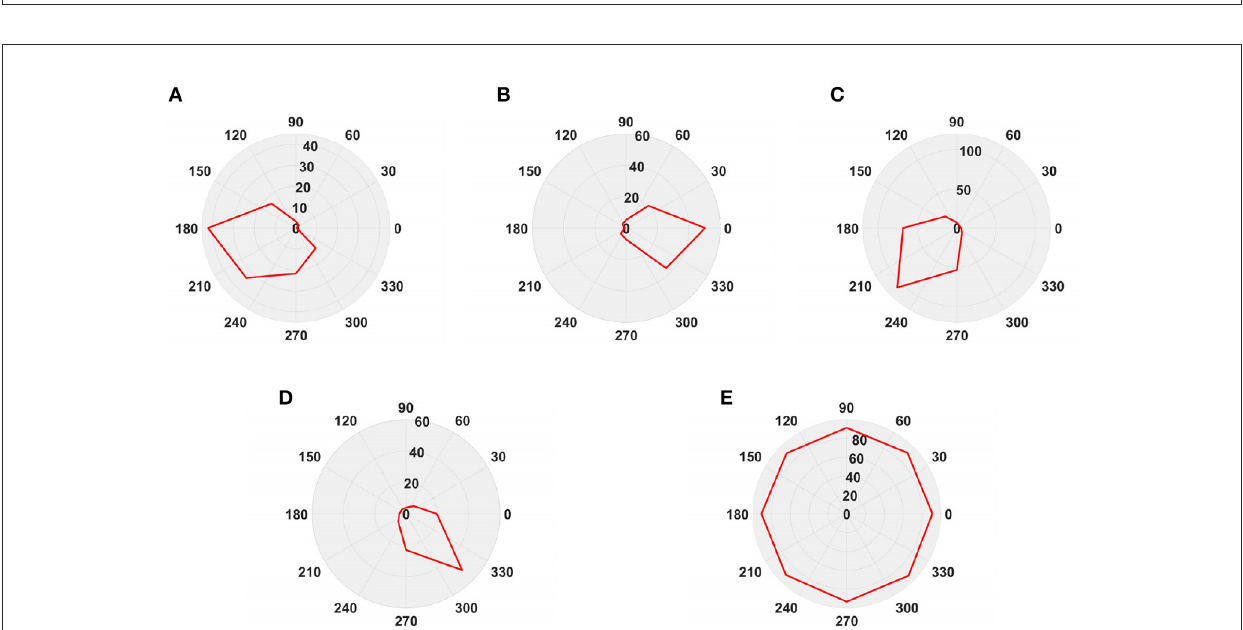
FIGURE11 The output direction of the directionally selective fractional-order LGMD collision sensing visual neural network. (A) The ball moves to the left. (B) The ball moves to the right. (C) The ball moves downwards to the left. (D) The ball moves downwards to the right. (E) The ball is looming moving toward the